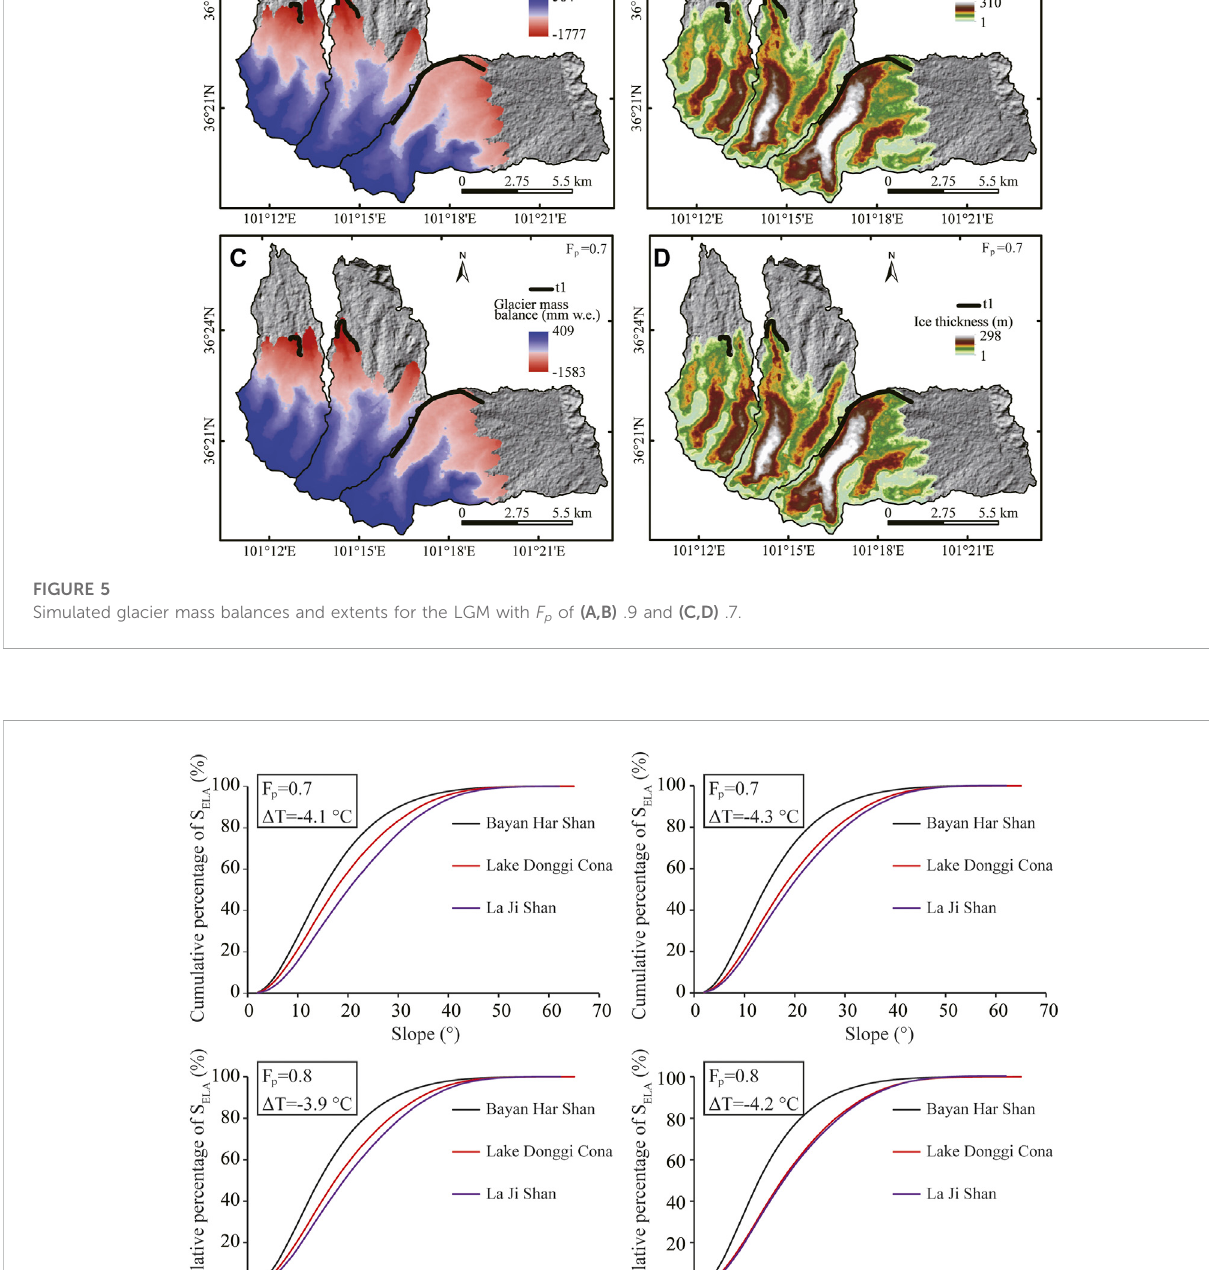
Frontiers in Earth